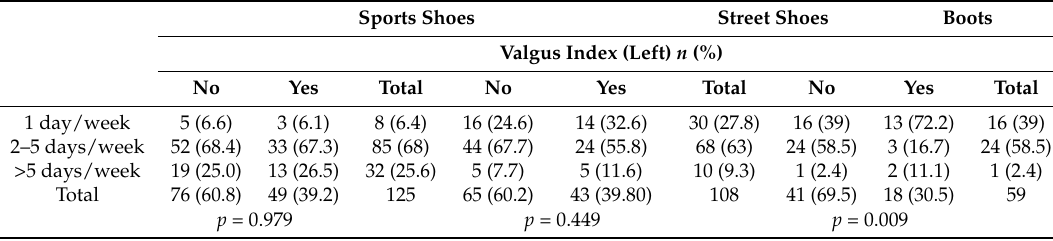
Table 2. Type and frequency of footwear and valgus